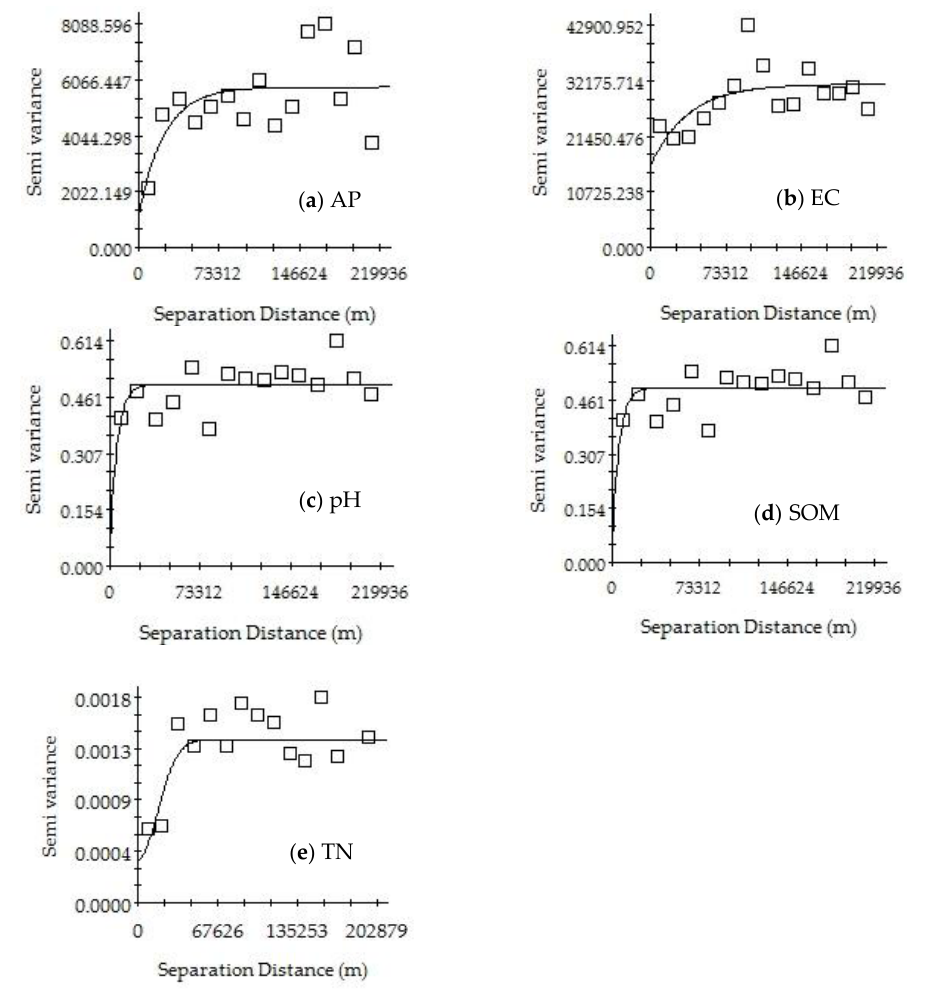
Figure 5. Variograms of AP ( a ), EC ( b ), pH ( c ), SOM ( d ) and TN ( e ) in the dry season of Mun River Basin.